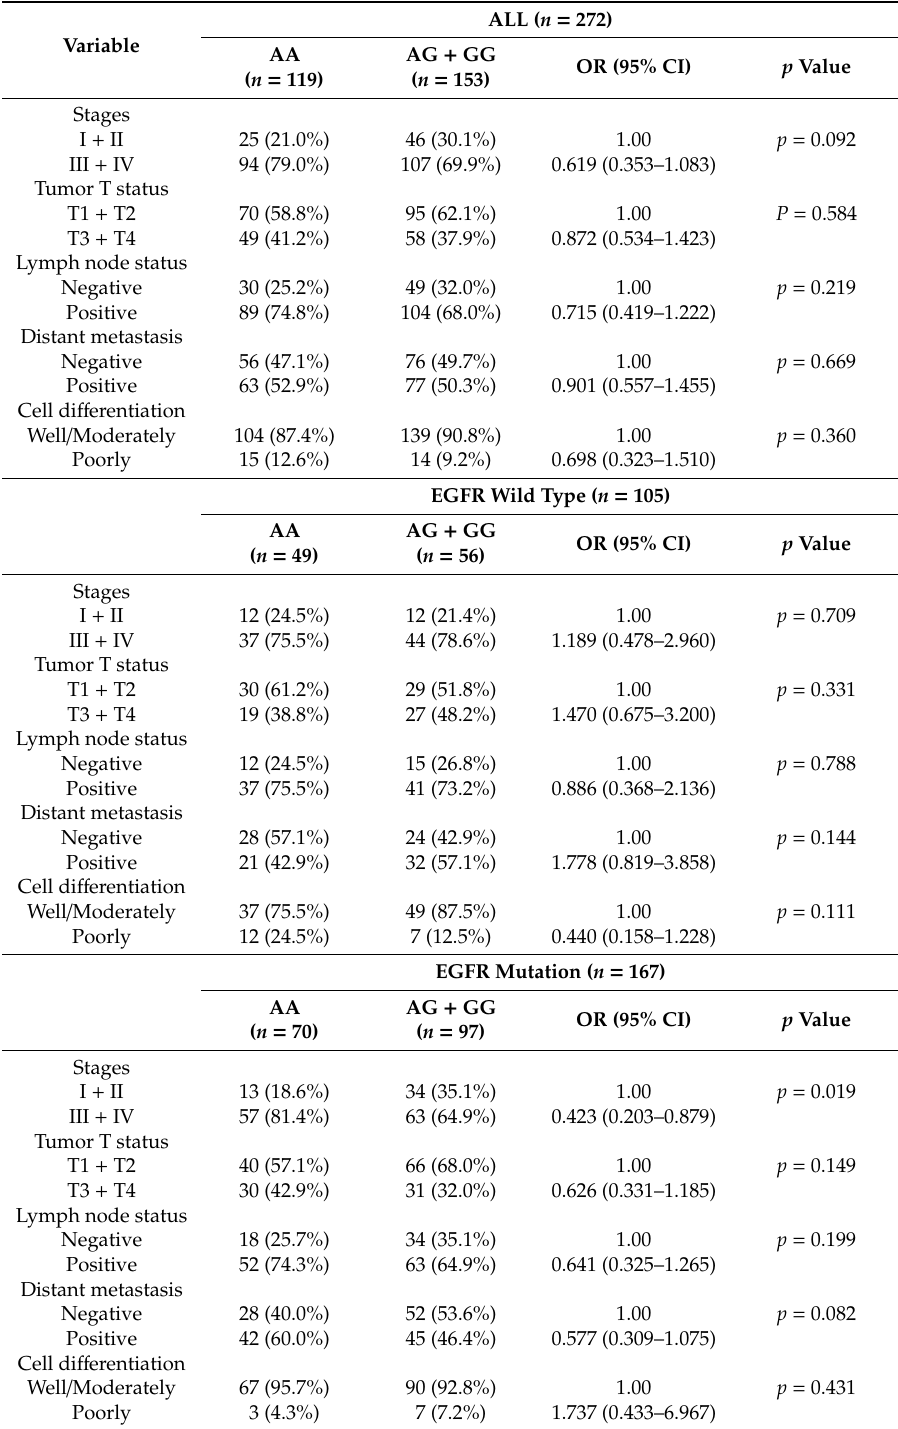
Table 5. Distribution frequency of AURKA rs6024836 genotypes with clinicopathologic characteristics in lung adenocarcinoma